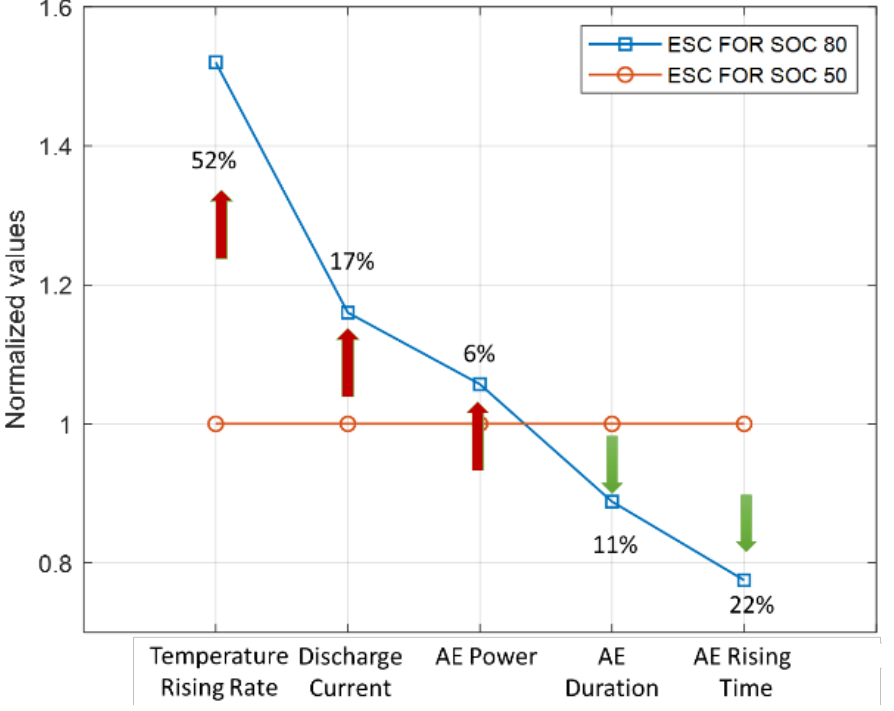
Figure 9. Comparison of main characteristic parameters of ESC occurrence.